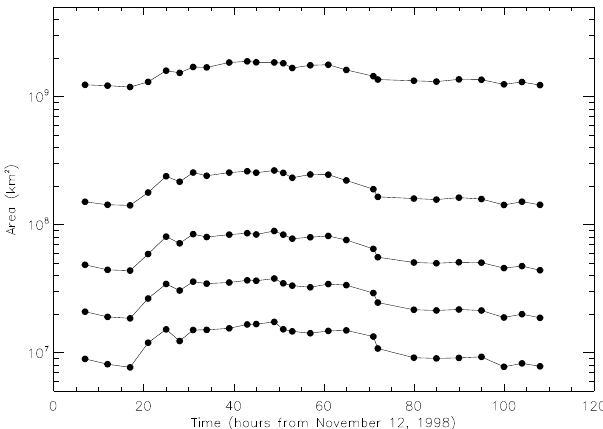
Figure 2. The variations of the area of the CRW for different rigidi- ties. The curves from bottom to top are for values of M t that are equal to 10, 20, 40, 100 and 500MV,